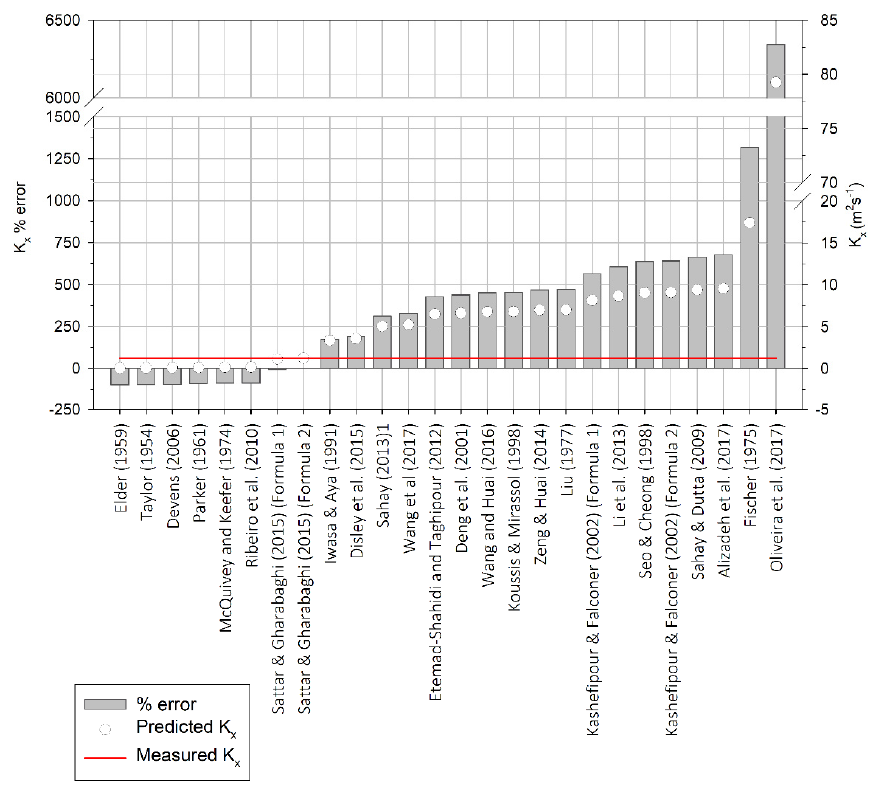
Figure 8. Percent error of the longitudinal dispersion coefficient value obtained with the predictive formulas when compared with the best-fit average value from the Hayami solution for the concrete channel (red line). Table 5. Relative error according to predictive formulas in the concrete